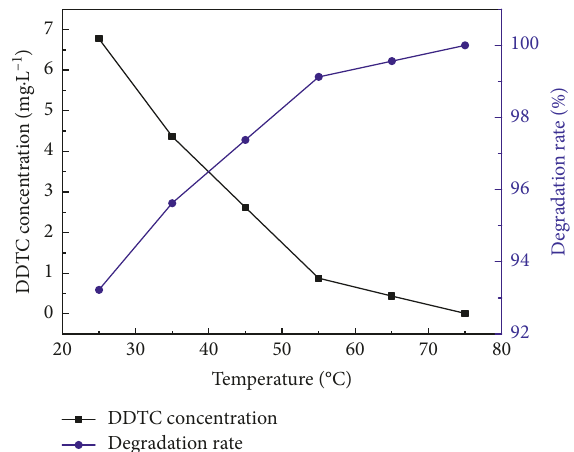
Figure 8: Influence of reaction temperature on the degradation of DDTC.